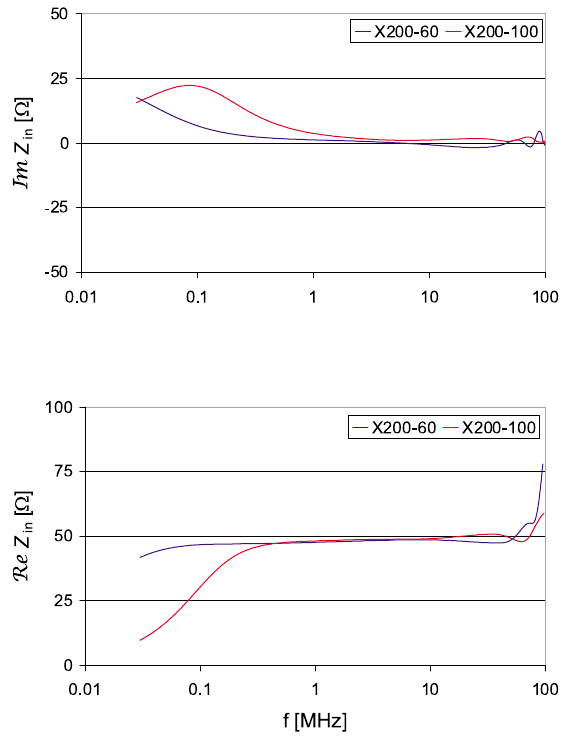
FIG. 4. (Color) Input impedance at transformers with different frequency